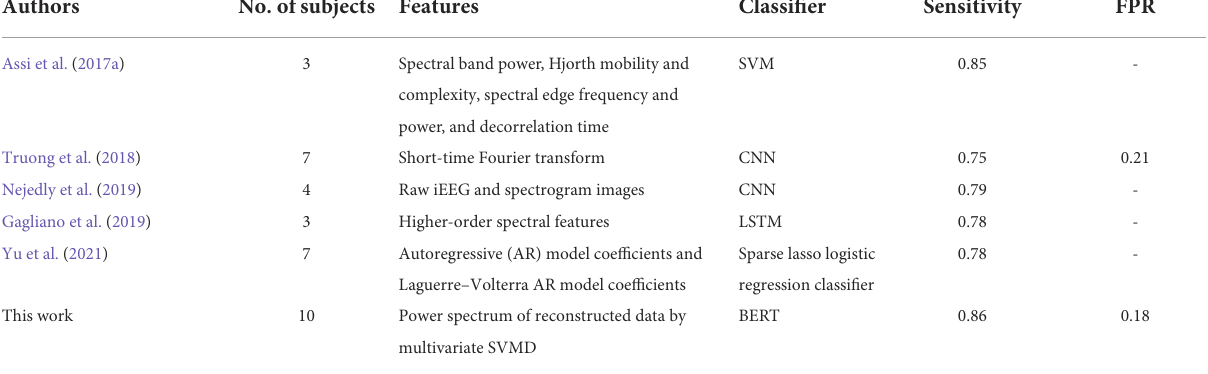
TABLE 5 Comparison of seizures prediction methods using iEEG dataset.